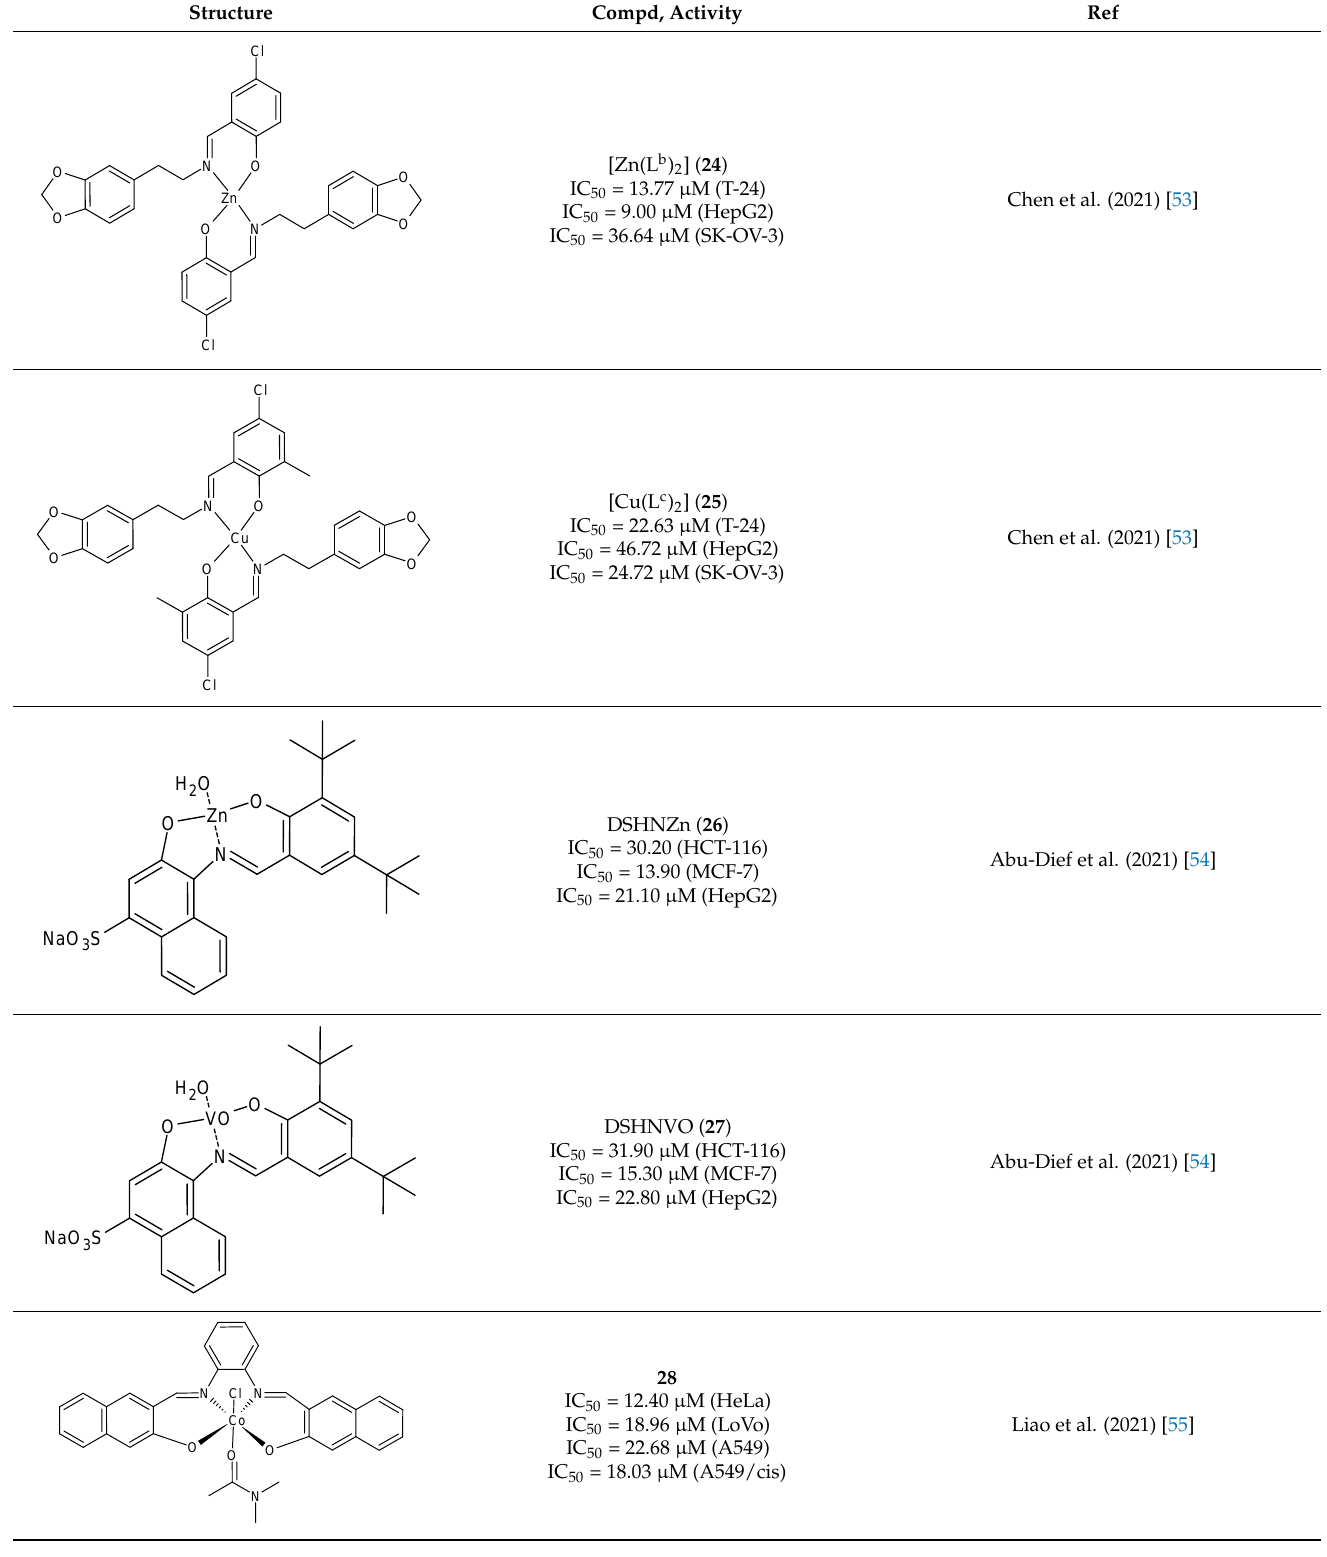
Table 2. Antiproliferative activity of Schiff base complexes with platinum group metals (PGM). structure